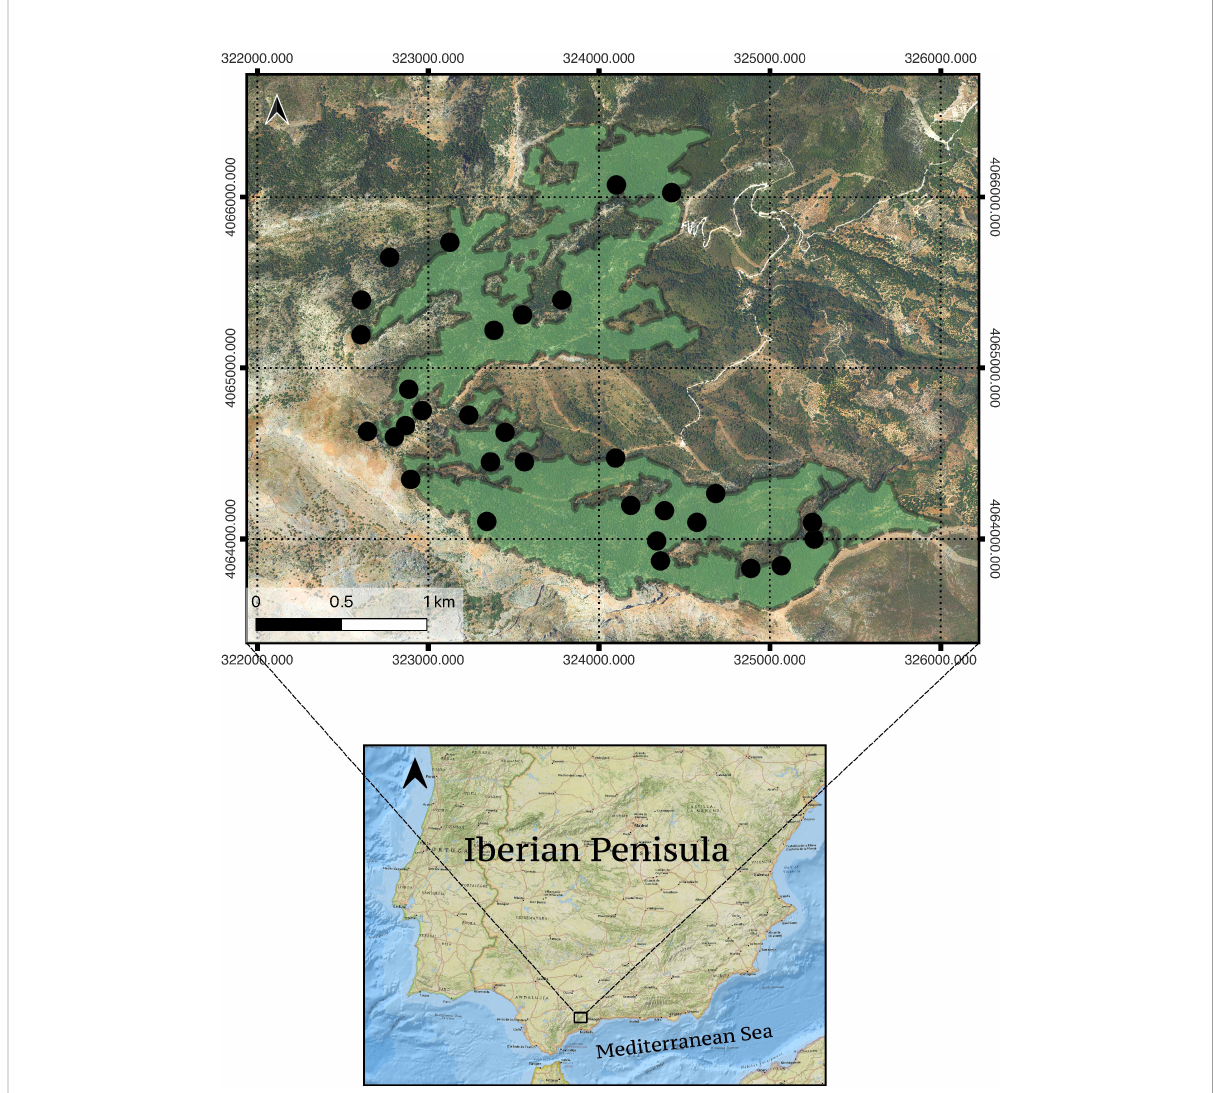
FIGURE 1 Study site location, Sierra de las Nieves National Park (Andalusia, south Spain). Green color patches show the areas of pure Abies pinsapo stands in the Yunquera forest (ca. 300 ha) used for both the Landsat and orthomosaic multitemporal analyses (resulting from the application of a -30m buffer to the pure Abies pinsapo mask to preclude the problem of mixed pixels; see 2.2 section). Black dots denote the location of the 31 plots used in the 2003 and 2020 fi eld surveys. Since the ‘ grain ’ component of the study scale in the remote sensing approach -30mx30m for Landsat imagery- is coarser than that applied in the fi eld-survey approach, some small pure stands included in the fi eld-survey were excluded after applying the -30m buffer and are not accounted for in the Landsat imagery analysis. This is why a few black dots in the Figure are outside the green area. The coordinate sytem employed was EPSG:25830 - ETRS89/UTM zone